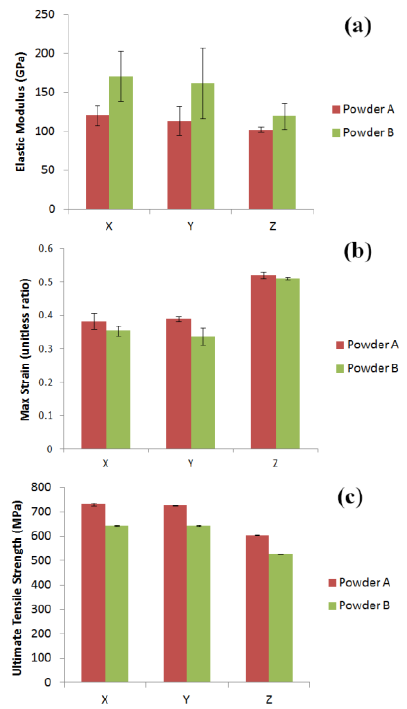
Figure 11. ( a ) Elastic moduli of parts produced using Powders A and B in X, Y and Z build orientations; ( b ) Max strain values exhibited by dogbone samples produced using Powders A and B as feedstock and ( c ) UTS values for samples from Powders A and B. Error bars are based on 95%